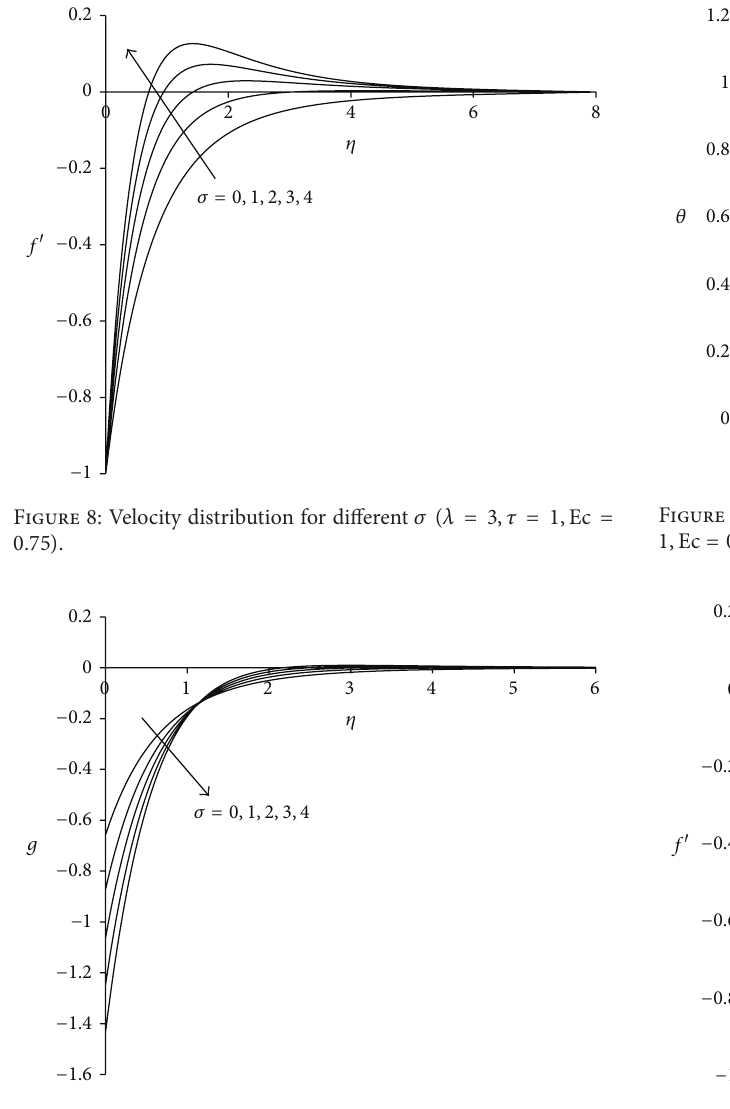
Figure 11: Velocity distribution for different Ec (𝜆 = 3, 𝜏 = 1, 𝜎 = 3)